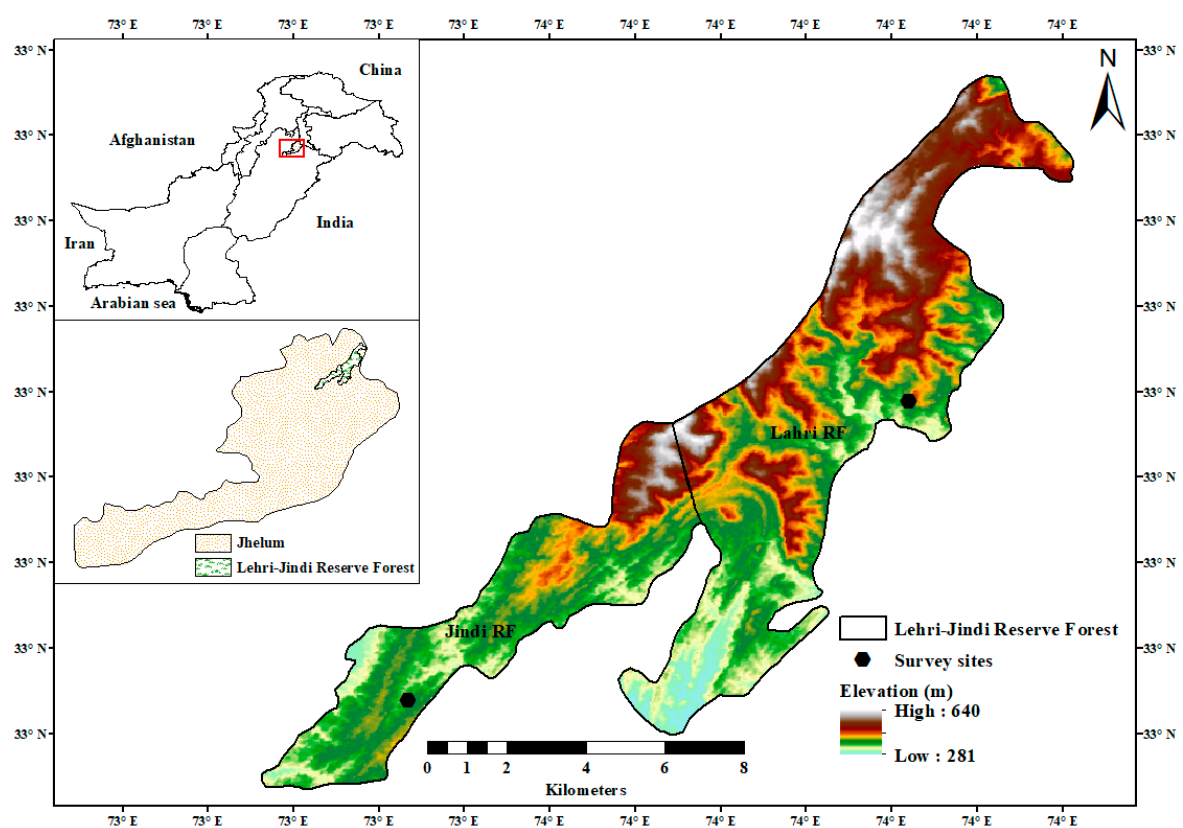
Figure 1. Map of the study area located in the north of the district Jhelum in the Punjab Province, Pakistan.